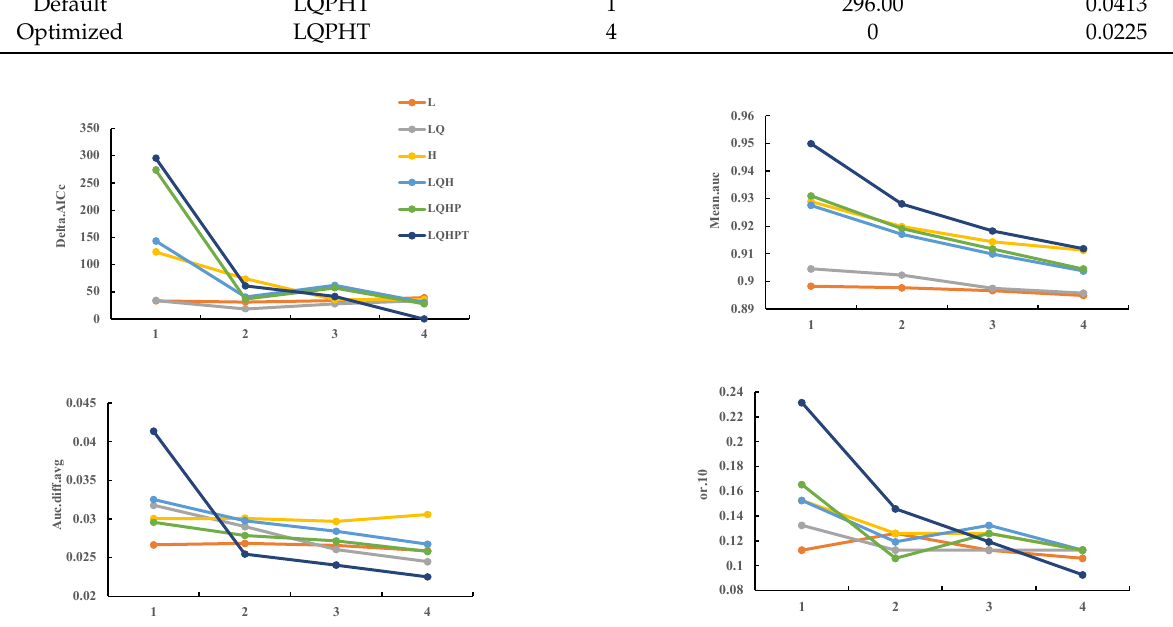
Figure 3. Performances of the maximum entropy model under different settings.